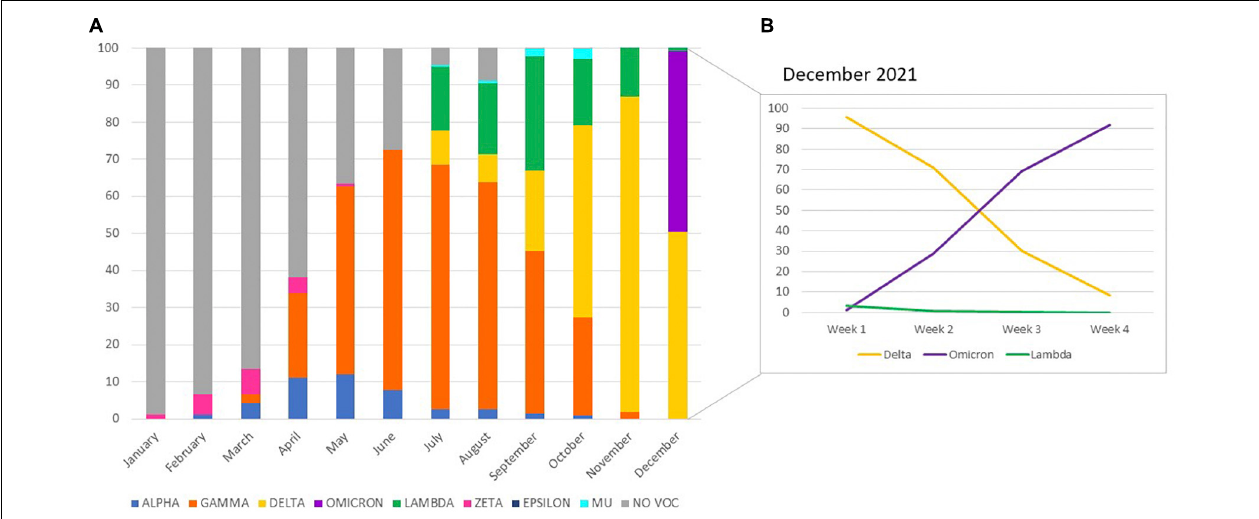
FIGURE 3 | Distribution of SARS-CoV-2 variants of concern (VOC) and interest (VOI) detected in the community from Córdoba province, Argentina, by real time RT-PCR, January to December 2021 (A) . The frequency of variant detections performed on December are shown by week (B)